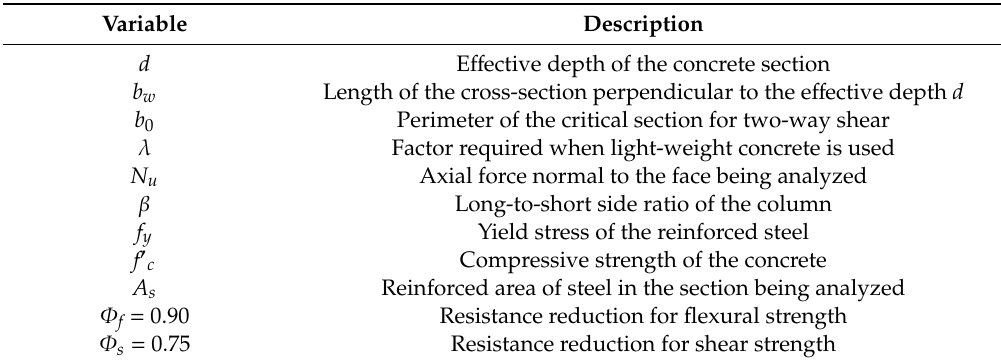
Table 1. Description of the variables